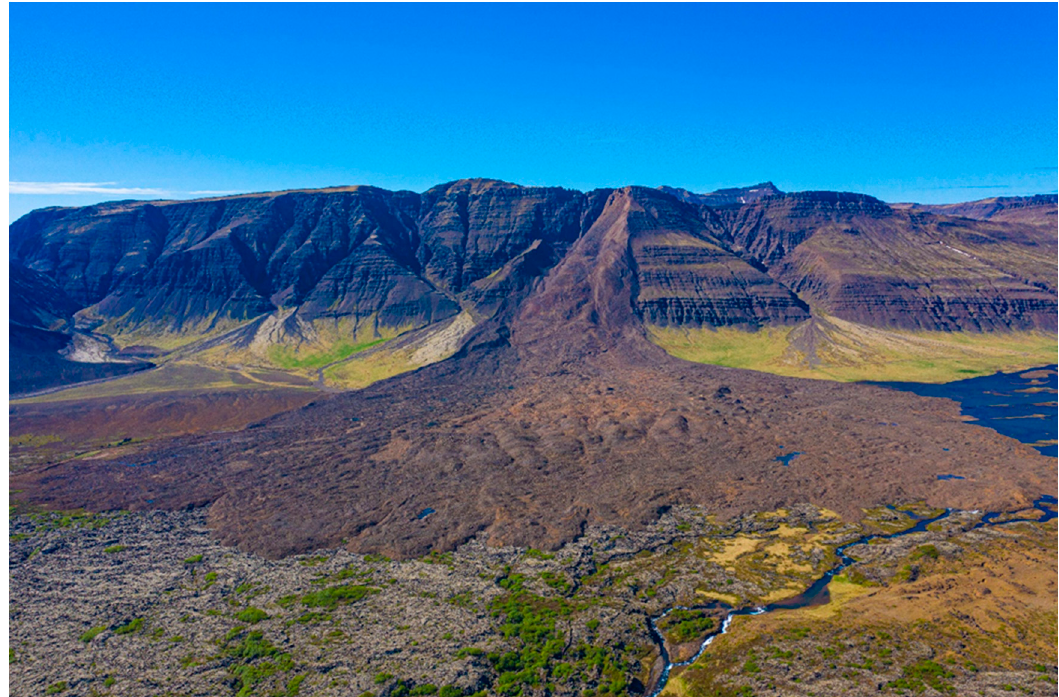
Figure 3. The Hítardalur landslide on the 7 July 2018 (location map is on Figure 8). The slide was initiated from the uppermost part of the mountain at 640 m a.s.l. The slide was about 2.3 km long and stopped at around 180 m a.s.l. (Photo by Sumarliði Ásgeirsson, 2018).